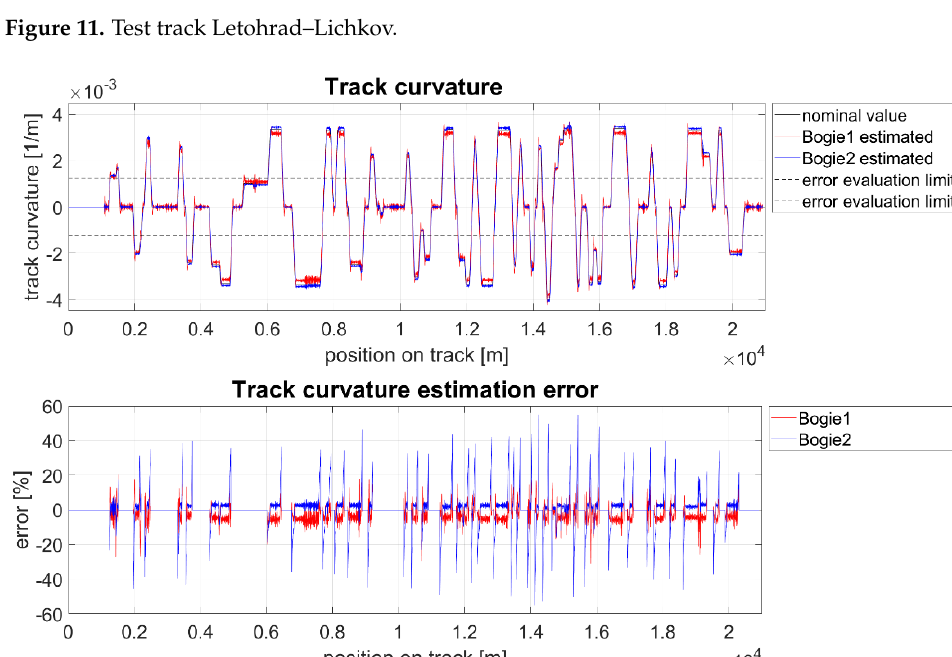
Figure 12. Simulation of the track Letohrad–Lichkov run for the friction coefficient f = 0.4. Compari- son of the nominal value of the track curvature and the track curvature estimated by bogie to car body angle measurement.